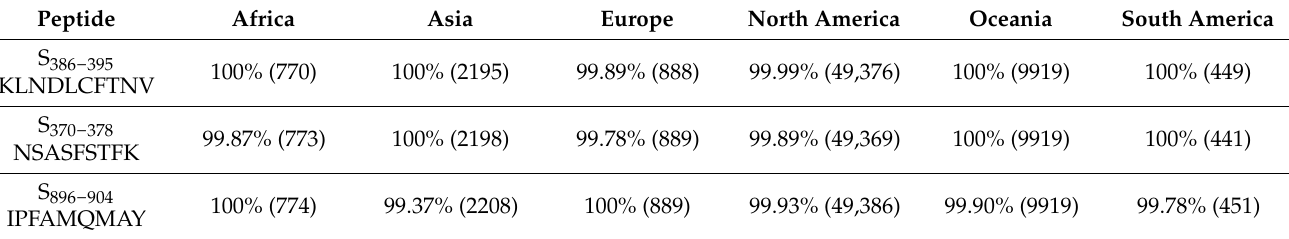
Table 2. Sequence conservation of the three spike-derived peptides study from SARS-CoV-2 isolates. Peptide Africa Asia Europe North America Oceania South